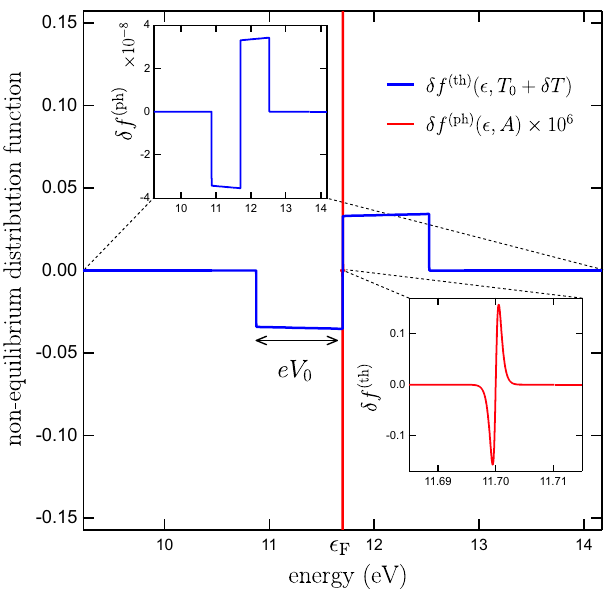
Fig. 6 Non-equilibrium distribution functions due to photon-assisted processes or heating. The settings parameters correspond to the measured one in subsection ''Hot-carrier vs thermal distribution": (cid:4) (cid:5) T ¼ 2 : 8K ; δ T ¼ 3K for heating and A exc = 10 − 8 for photon 0